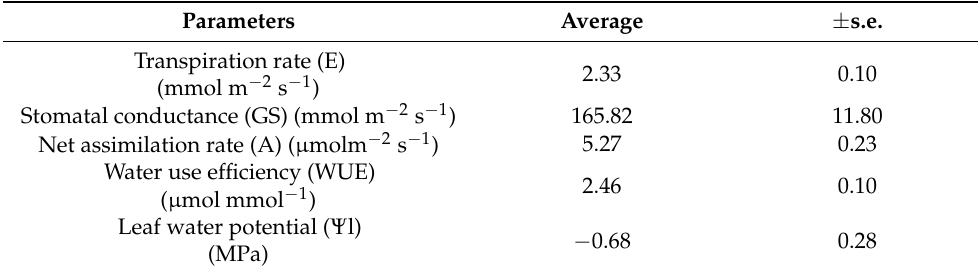
Table 2. Average values of some eco-physiological parameters in ‘Victoria’, ‘Matilde’, and ‘Black Magic’ table-grape soil-less cultivation z . Parameters Average ±